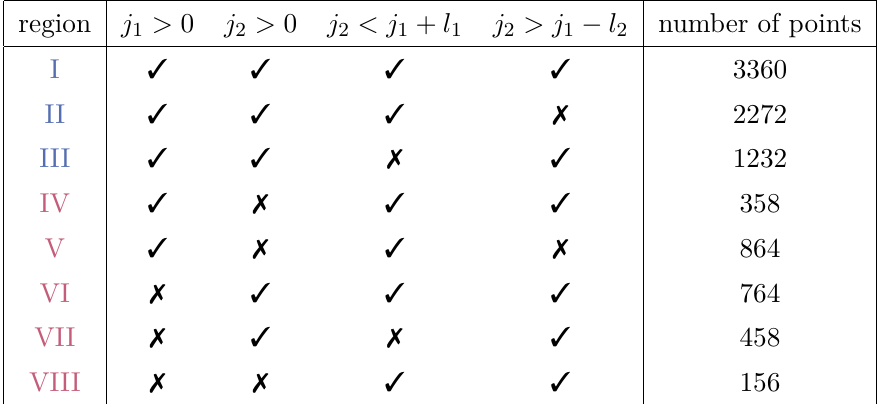
Table 7 . The eight regions of the summation variables { j 1 , j 2 , l 1 , l 2 } and the values of the predicates introduced in eq. (4.29) that separate them. Here we denote { 3 , 7 } = { true , false } . The total number of points (or terms in the sums) in each region is evaluated for the expansion order x 25 , which corresponds to j 1 + j 2 + l 1 + l 2 ≤ N opt (12) = 25 . In figure 3 we also illustrate these regions on the { j 1 , j 2 }